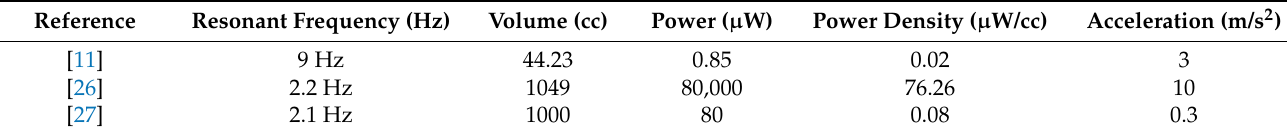
Table 1. Ferrofluid sloshing vibration energy harvesting configurations published in literature.